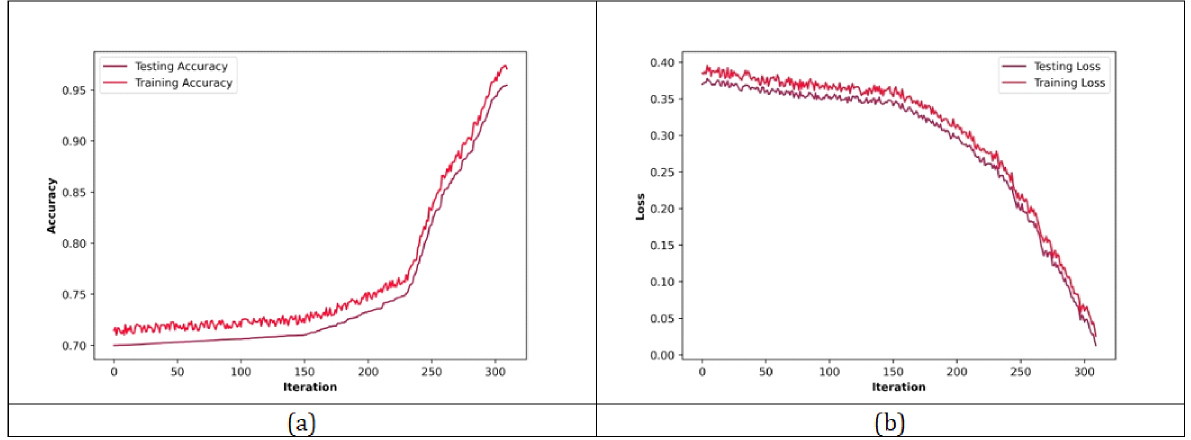
Figure 7. Performance analysis based on ( a ) accuracy and ( b ) loss for Sentiment Classification using social media app review dataset.